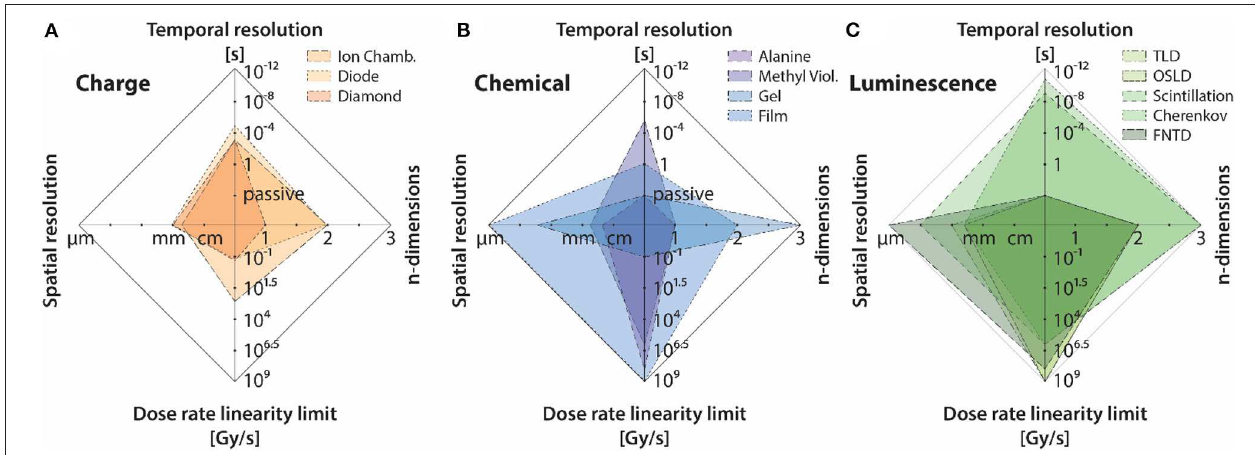
The color scheme of the “Response” and “Detectors” panel matches the spider plots in Figure 14 . Performance of each dosimeter for a specific parameter is color coded: green (good), yellow (moderate), and red (poor).